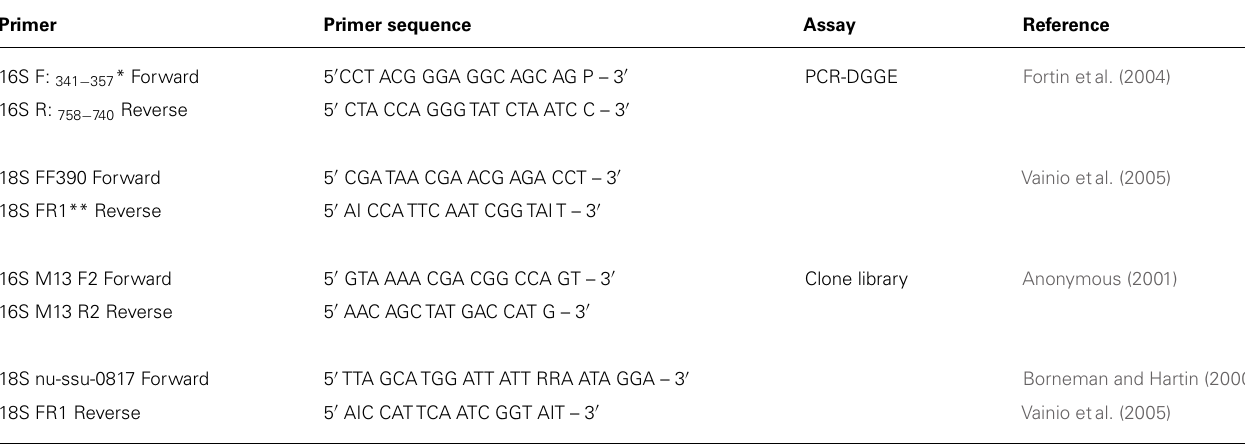
Table 1 | Primers used to amplify 16S and 18S rRNA genes of microbes in soil microcosms. Primer Primer sequence Assay